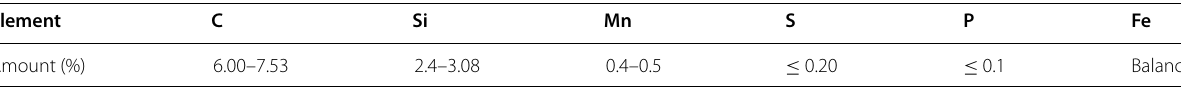
Table 1 Chemical compositions of MCI Element